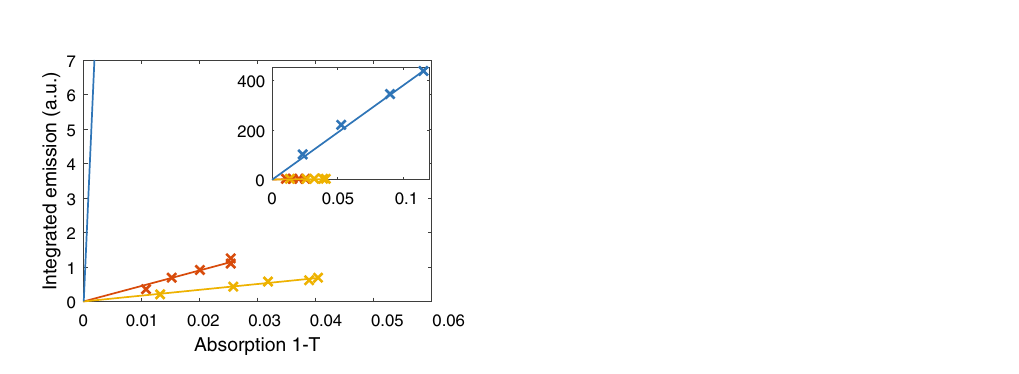
Figure 3. Fluorescence intensity integrated over all wavelengths as a function of the number of absorbed photons at the excitation wavelength for Cfl. aurantiacus (red line), Cba. tepidum (yellow line) and for BChl c monomers (blue line). The inset shows the data on an extended scale.